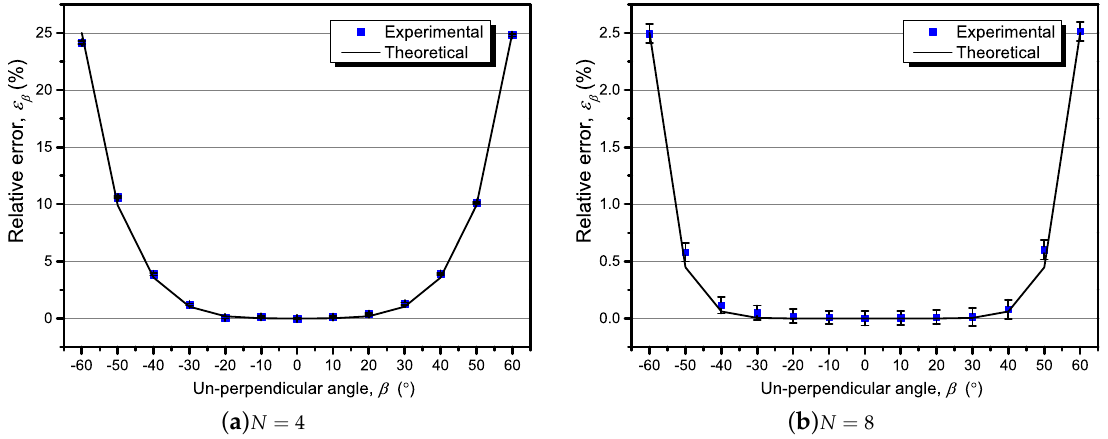
Figure 8. The un-perpendicular effect with the offset angle β varying from − 60 ◦ to 60 ◦ , with d = 0, α 0 = 0 ◦ , and test current f = 400 Hz @ 50